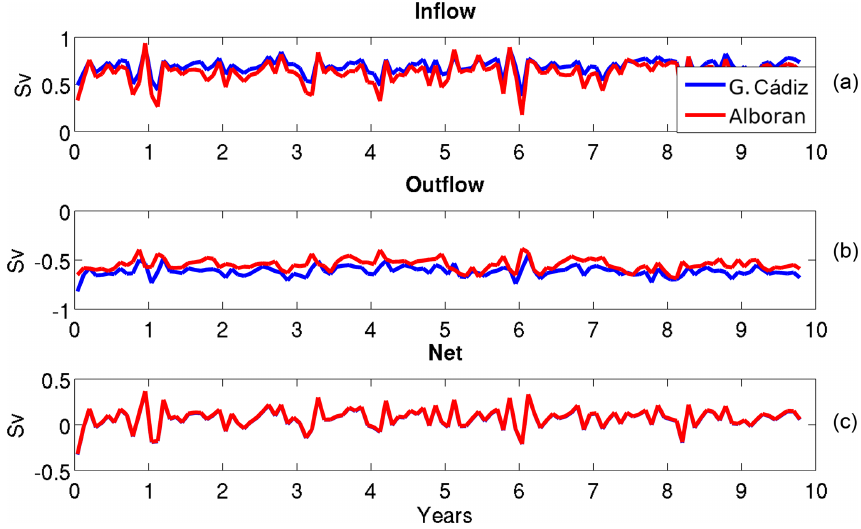
Figure 4. Monthly averages of the 3-hourly transports at the outer sections, Gulf of Cádiz (blue) and Alborán (red). The inflow (a) , outflow (b) and net transport (c) are